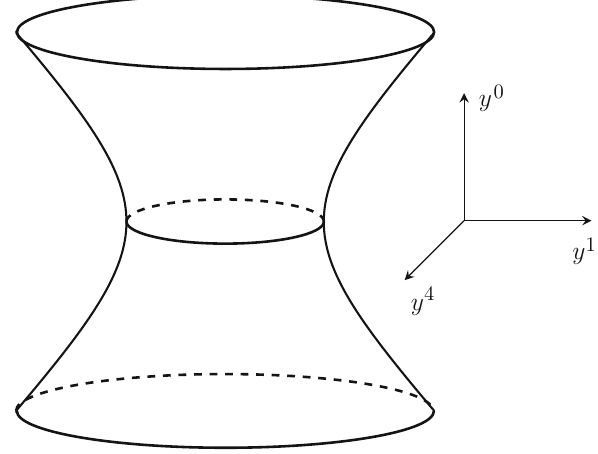
Fig. 1 The complete de Sitter manifold in four dimensions, where the y 2 and y 3 coordinates have been suppressed